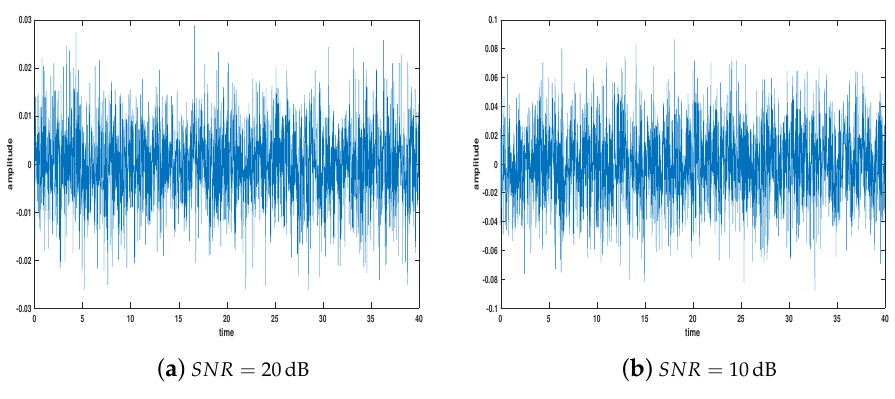
The error between the true output y ( t ) and ˆ y ( t ) is plotted in Figure 8.